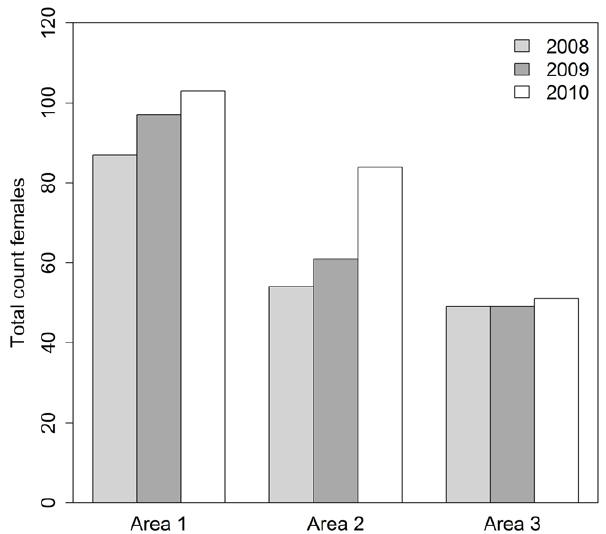
Figure 5. Comparison of the annual count in summer (August) of females of all age classes for areas 1, 2, and 3 (west to east) from 2008 to 2010, Sable Island, Canada.